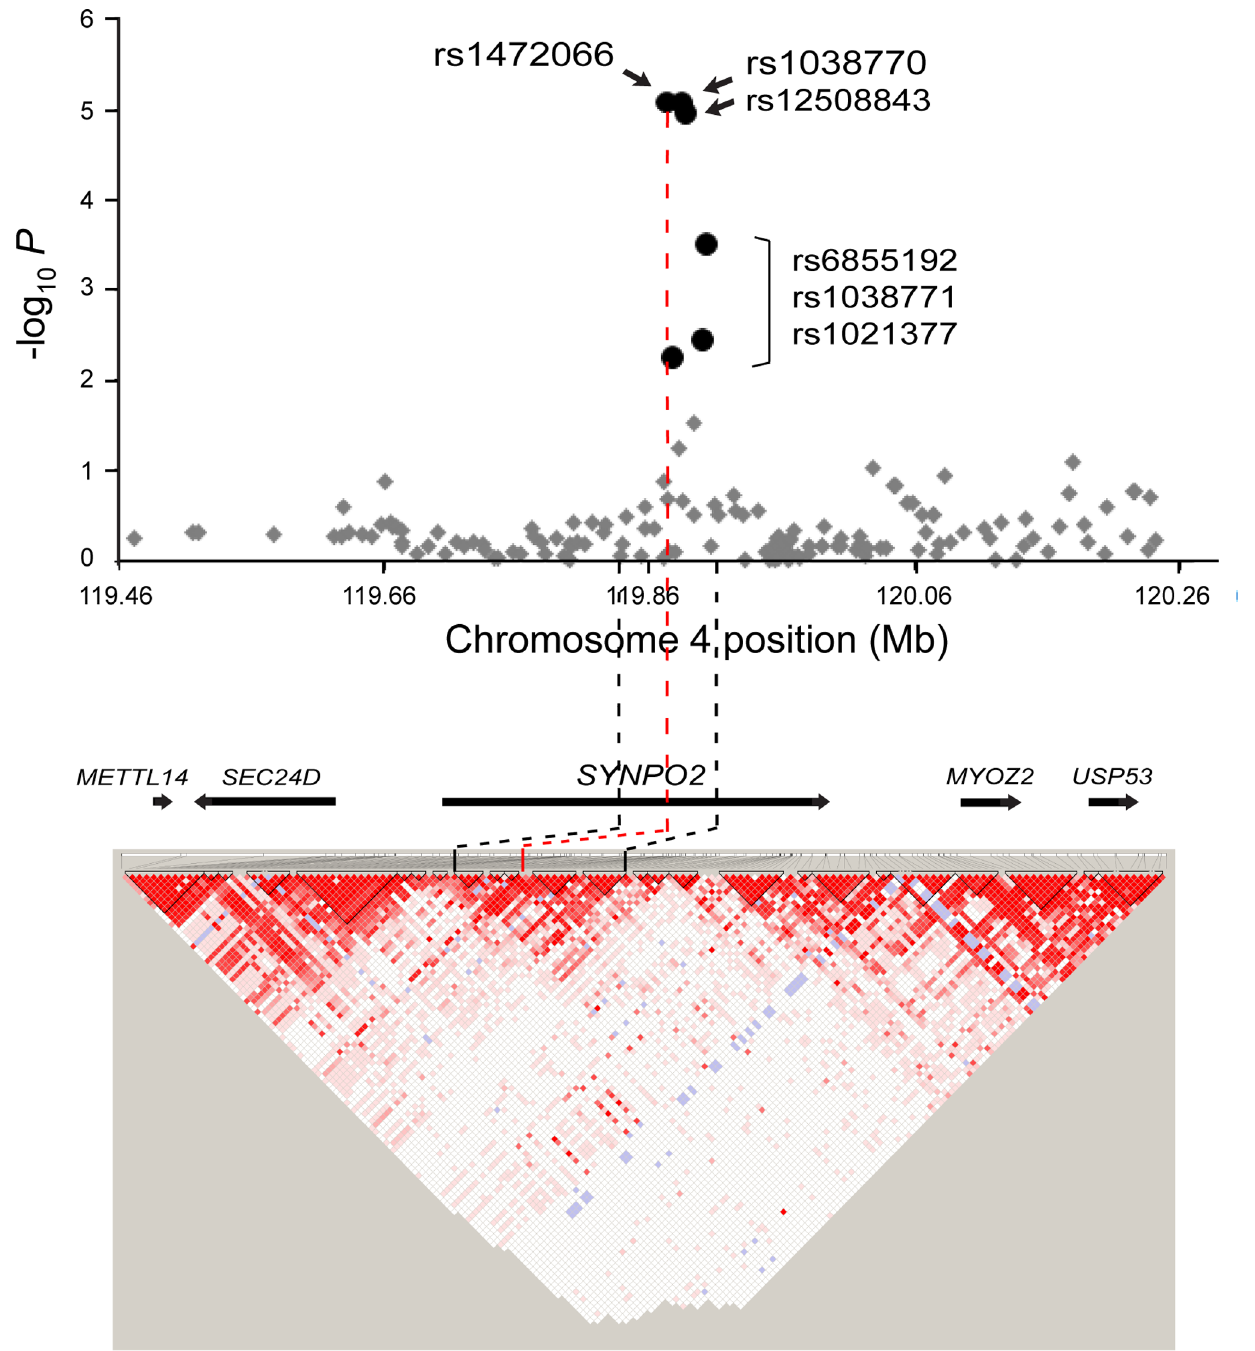
Figure 2. Regional association plot and LD of SYNPO2 for the total IgE in asthmatics. GWAS associations (-log 10 P ) of SNPs across approximately 768 kb region around SYNPO4 in the chromosome 4q26 are shown. Relatively strong associations are shown as large black circles; relatively less significances as small gray diamonds.